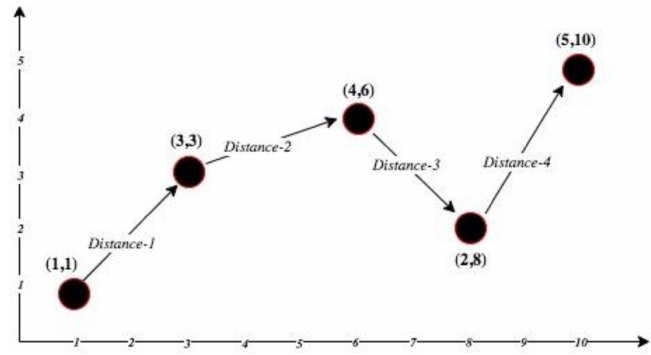
Figure 9. Length of